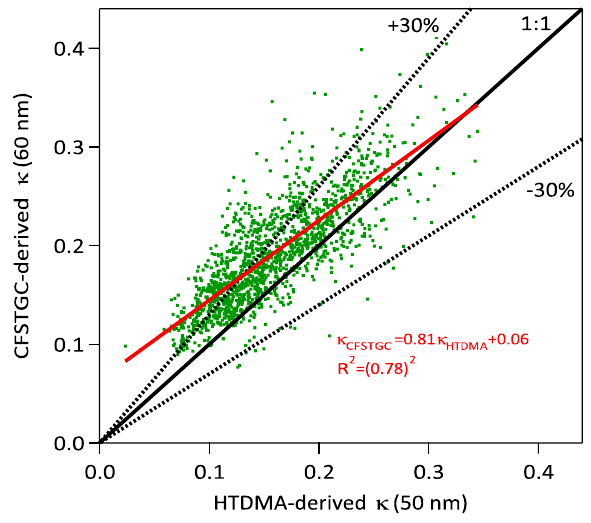
Fig. 5. CFSTGC-derived κ values for 60nm diameter particles against HTDMA-derived κ values for 50nm diameter particles. 1020 Shown is a best fit line (red), 1:1 line (black, solid), and lines of ± 30% deviation (black,